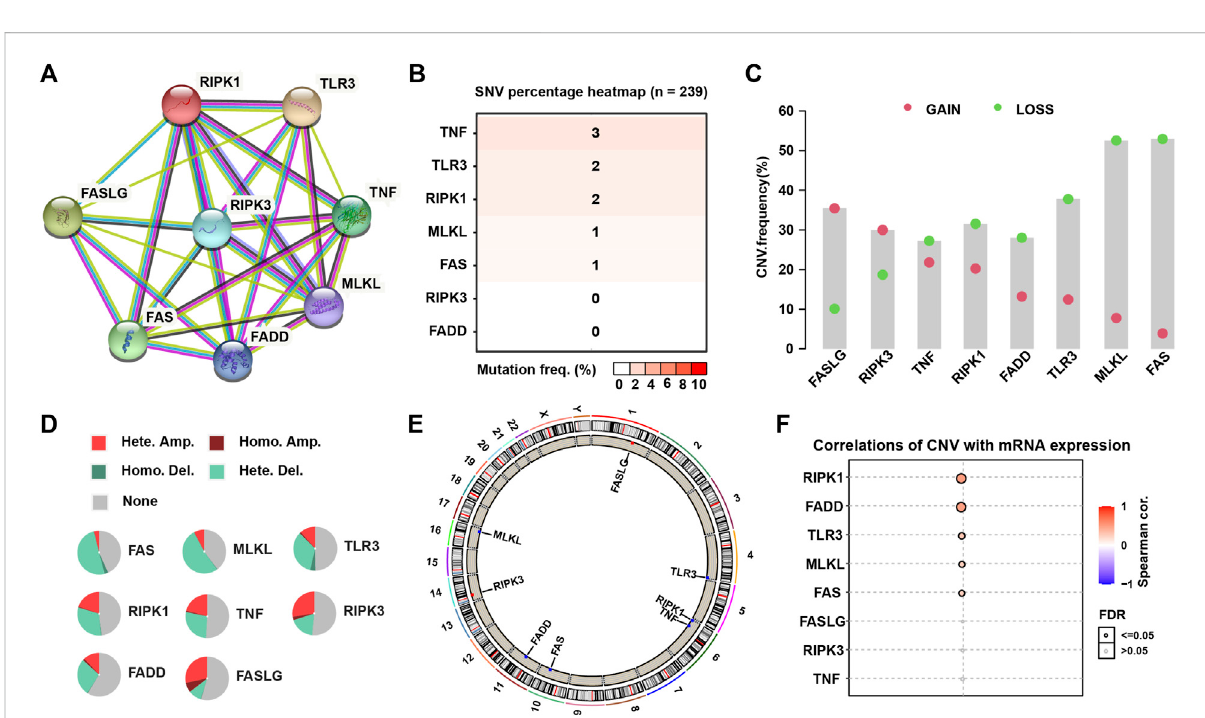
FIGURE 2 The PPI network and genetic alteration of necroptosis genes. (A) The PPI network of the eight necroptosis genes. (B) The SNV frequency of necroptosis genes in 239 SARC samples. (C) Frequencies of gain and loss CNV of necroptosis genes. (D) Pie plots presenting CNV percentages of necroptosis genes. (E) Chromosome locations of necroptosis genes. (F) The correlation between mRNA expression of necroptosis genes and their